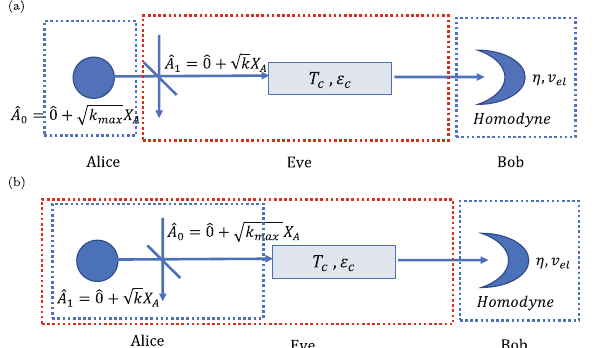
Fig. 6 CV QKD system for case (2B). ( a ) Untagged Gaussian state ( k ≤ k max ) ( b ) Tagged Gaussian state k > k max . Here, we show the CV QKD system with untagged and tagged Gaussian states. Suppose that Alice always records the data as